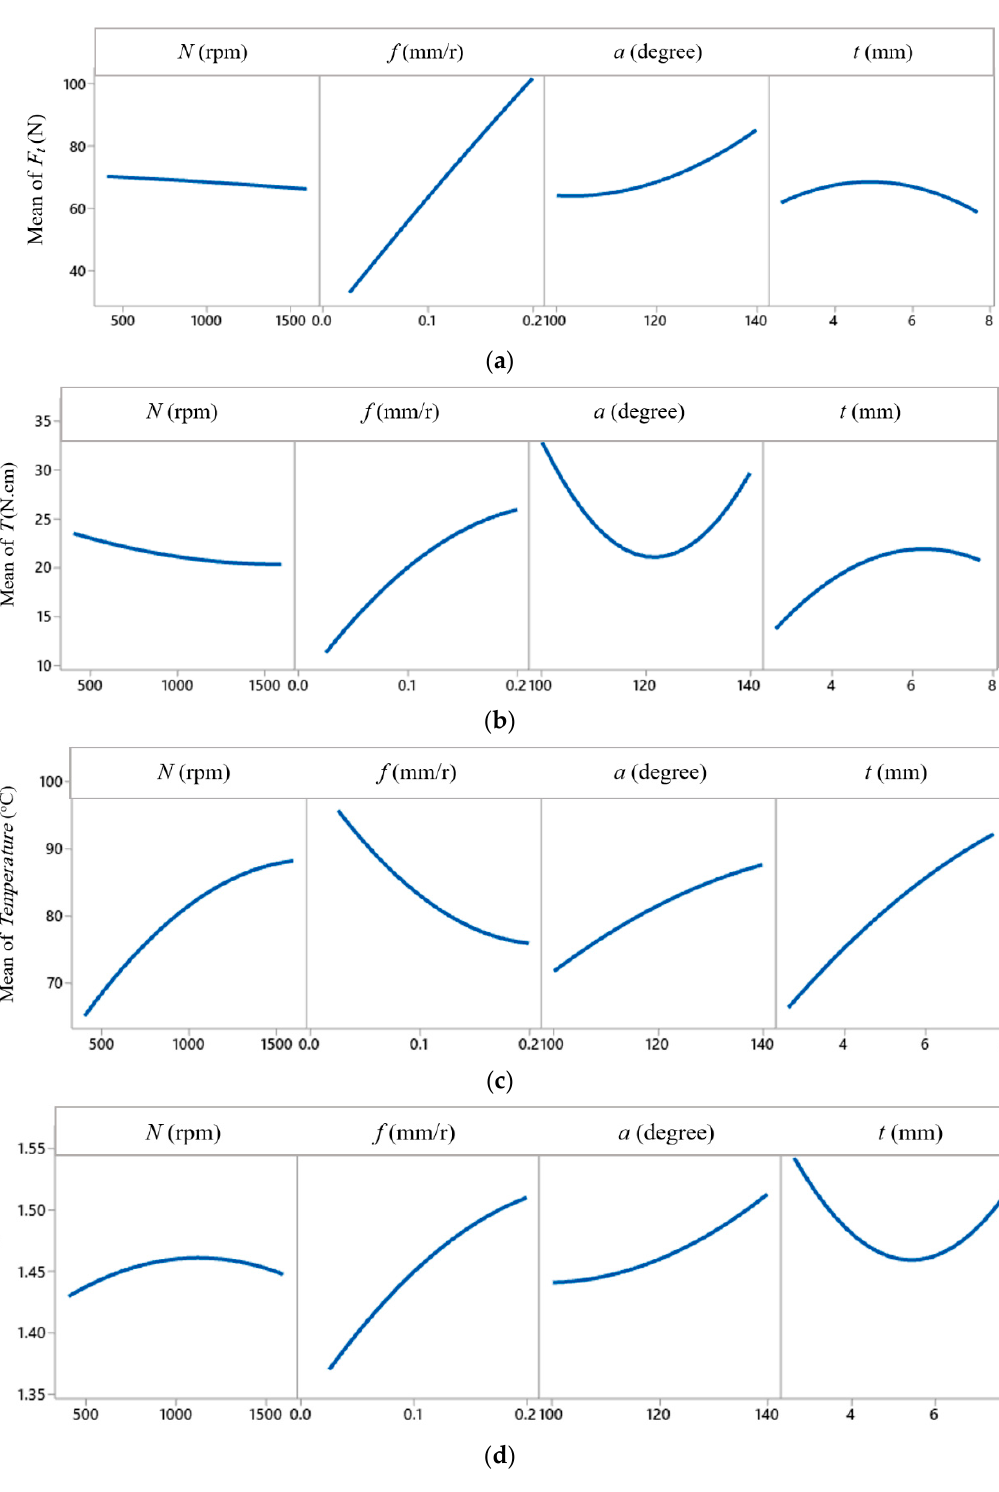
Figure 11. Main effect plots: ( a ) Ft (N), ( b ) T (N.cm), ( c ) temperature ( ◦ C), and ( d ) Fd-out. Figure 12 illustrates 3D surface and contour plots of machinability responses versus different drilling parameters of GFRP composite with a thickness of 5.3 mm, as a repre- sentative sample. These plots can easily indicate the critical conditions for the predicted machinability properties. For example, at the feed of 0.2 mm/r, the critical thrust force was observed at speed of 400 rpm, as shown in Figure 12a. Similarly, the critical temperature was observed at the feed of 0.025 mm/r and speed of 1600 rpm using a drill with a